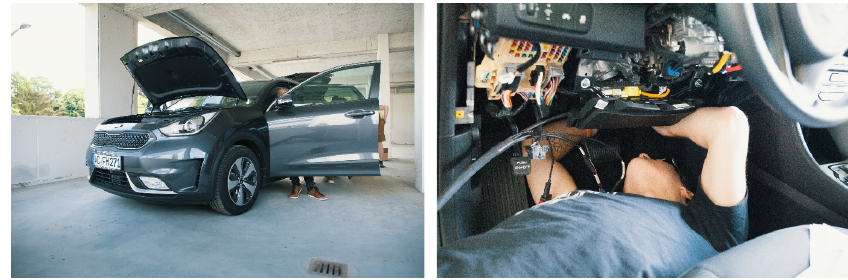
Fig. 7. Converting a KIA Niro (photos: FH Aachen, Daniel